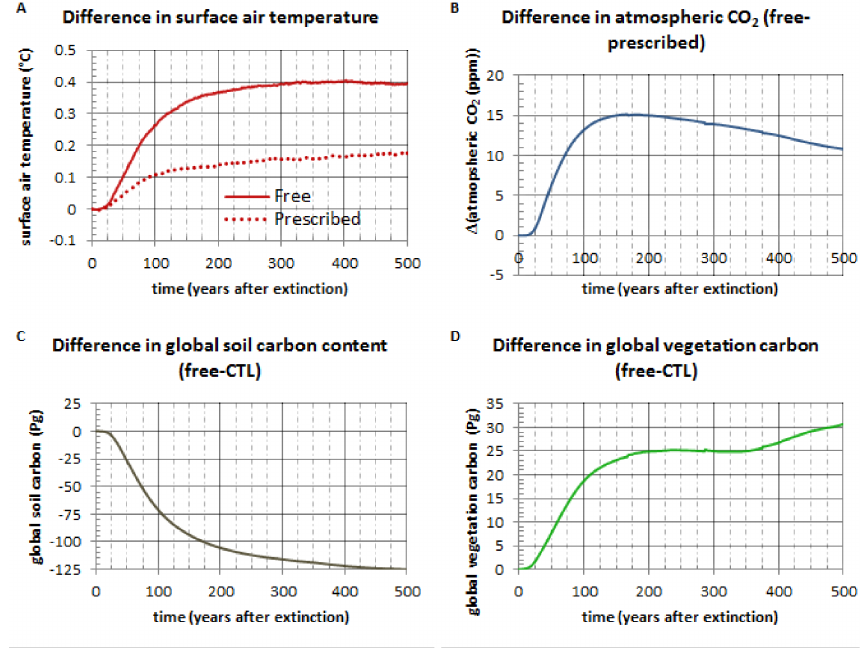
Fig. 8. A selection of results from the “free CO 2 ” experiment. Displayed are (a) the difference in temperature (EXT-CTL) for the free and prescribed CO 2 experiments (dotted line is the same as dotted line in Fig. 1c); (b) the difference in atmospheric CO 2 between the two simulations; (c) the difference in total soil carbon and (d) the difference in total vegetation carbon resulting from the vegetation